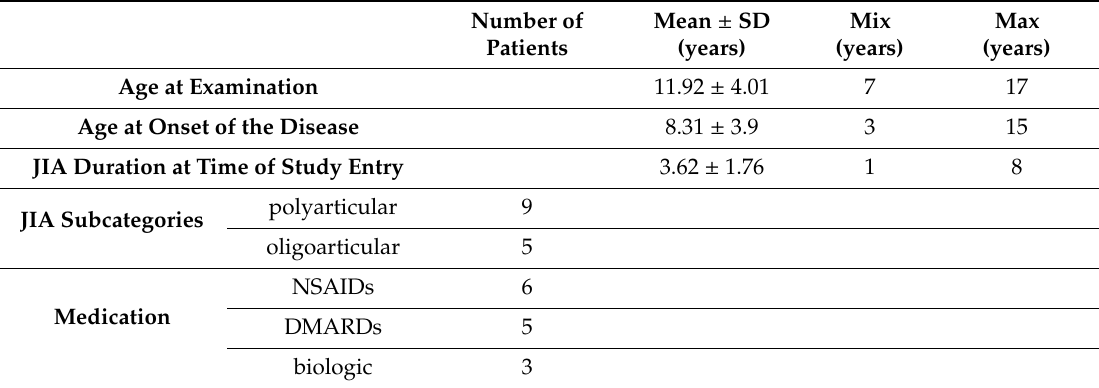
Table 2. Clinical characteristic of juvenile idiopathic arthritis patients included in the study.